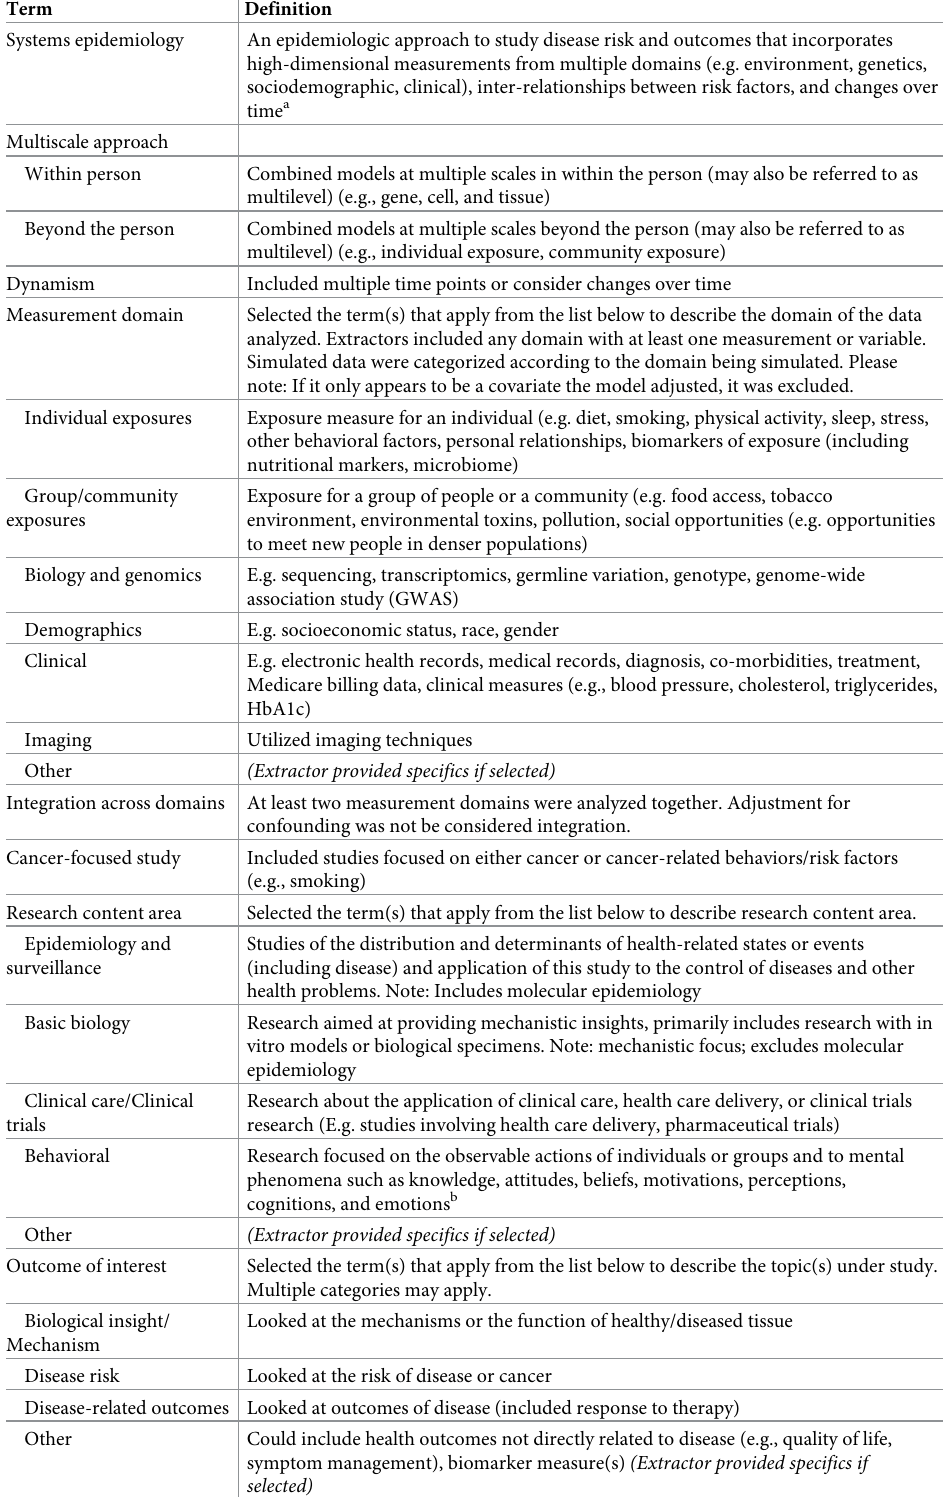
Table 2. Definitions of specific aims characteristics used during